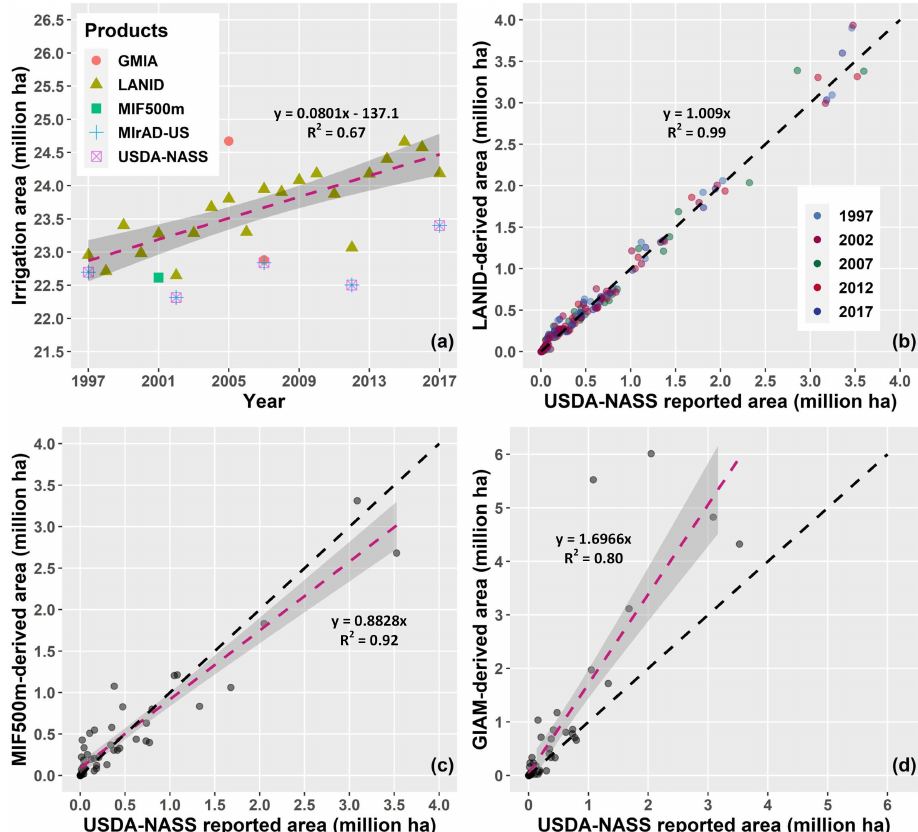
Figure 14. Comparisons of irrigated area between products at the nation (a) and state (b–d) levels. (a) LANID-derived nationwide irrigation trend (dashed pink line) and irrigated area of other products. (b) USDA-NASS-reported vs. LANID-estimated irrigation area for 5 census years. (c) USDA-NASS-reported (2002) vs. MODIS-estimated (2001) irrigated area (adapted from Ozdogan and Gutman, 2008). (d) USDA- NASS reported (2002) vs. GIAM-estimated (2000) irrigated area. Note the GIAM-estimated nationwide irrigated area (39 × 10 6 ha) is not shown in (a) due to its exceptionally high value. State-level comparisons between USDA-NASS and MIrAD-US and GMIA are not demonstrated because both products used census data as